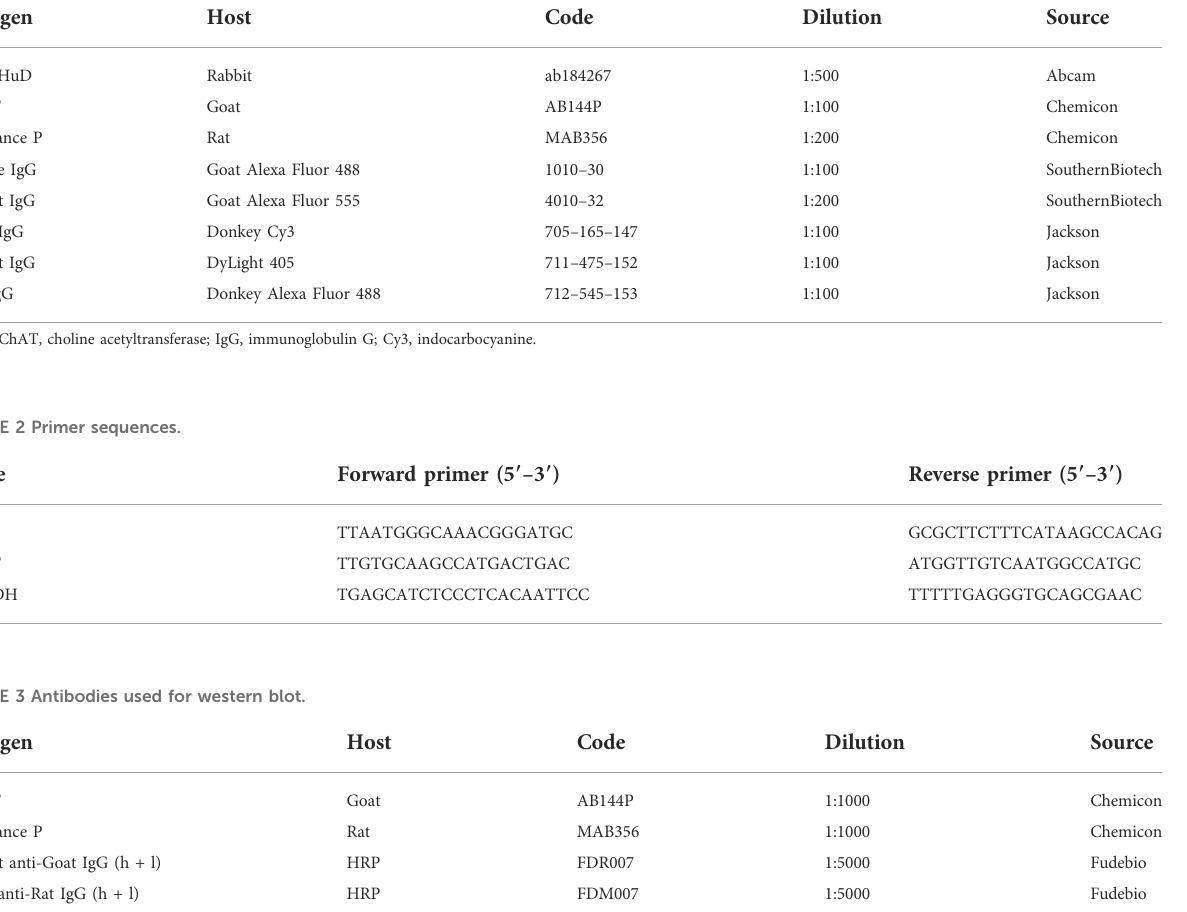
TABLE 1 Antibodies used for immunohistochemistry.